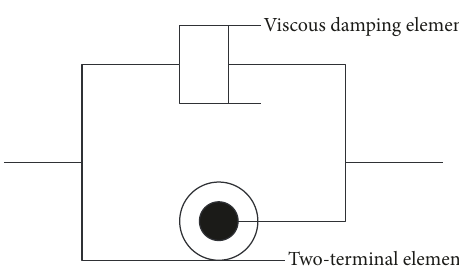
Viscous damping element